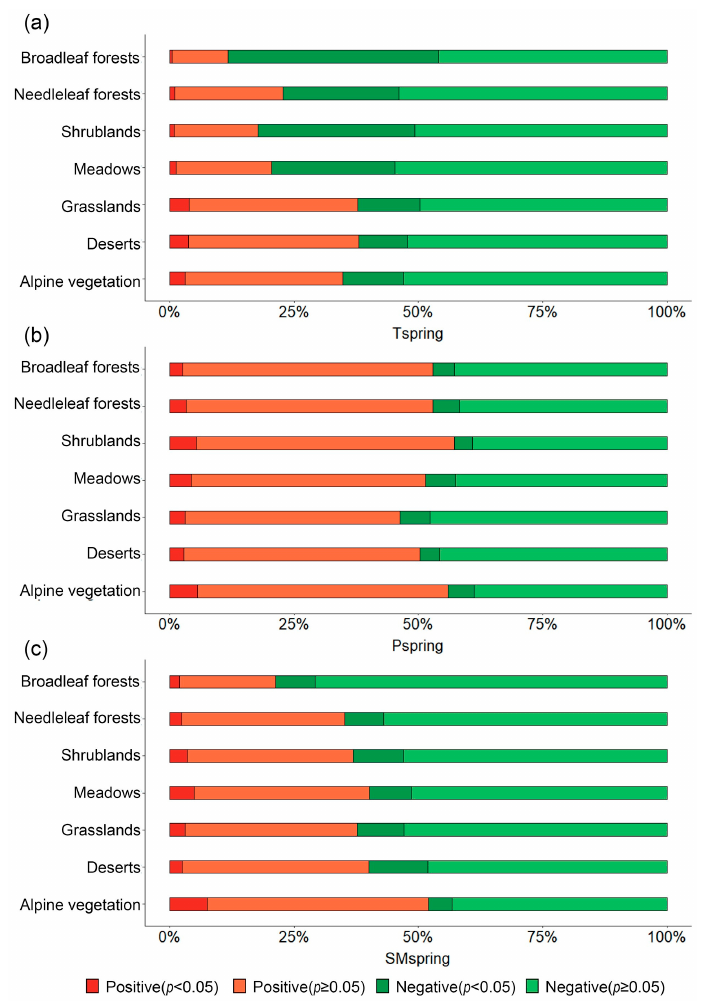
Figure 8. Percentages of correlation between the SOS and three driving factors in different vegeta- tion types. The three driving factors were ( a ) spring temperature (Tspring), ( b ) spring precipitation (Pspring), and ( c ) spring soil moisture (SMspring).